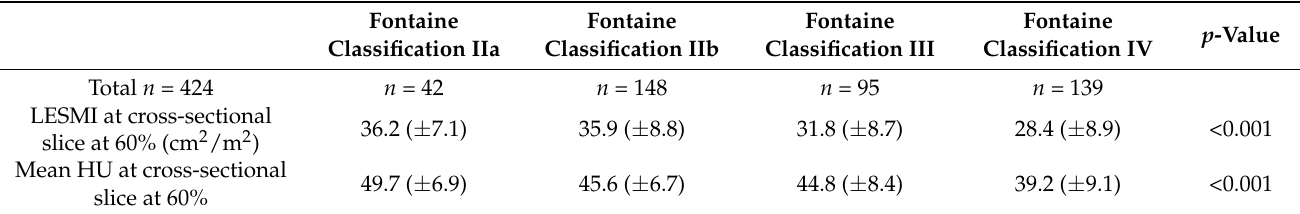
Table 2. LESMI and Mean HU of treated legs of PAD patients divided by disease severity.